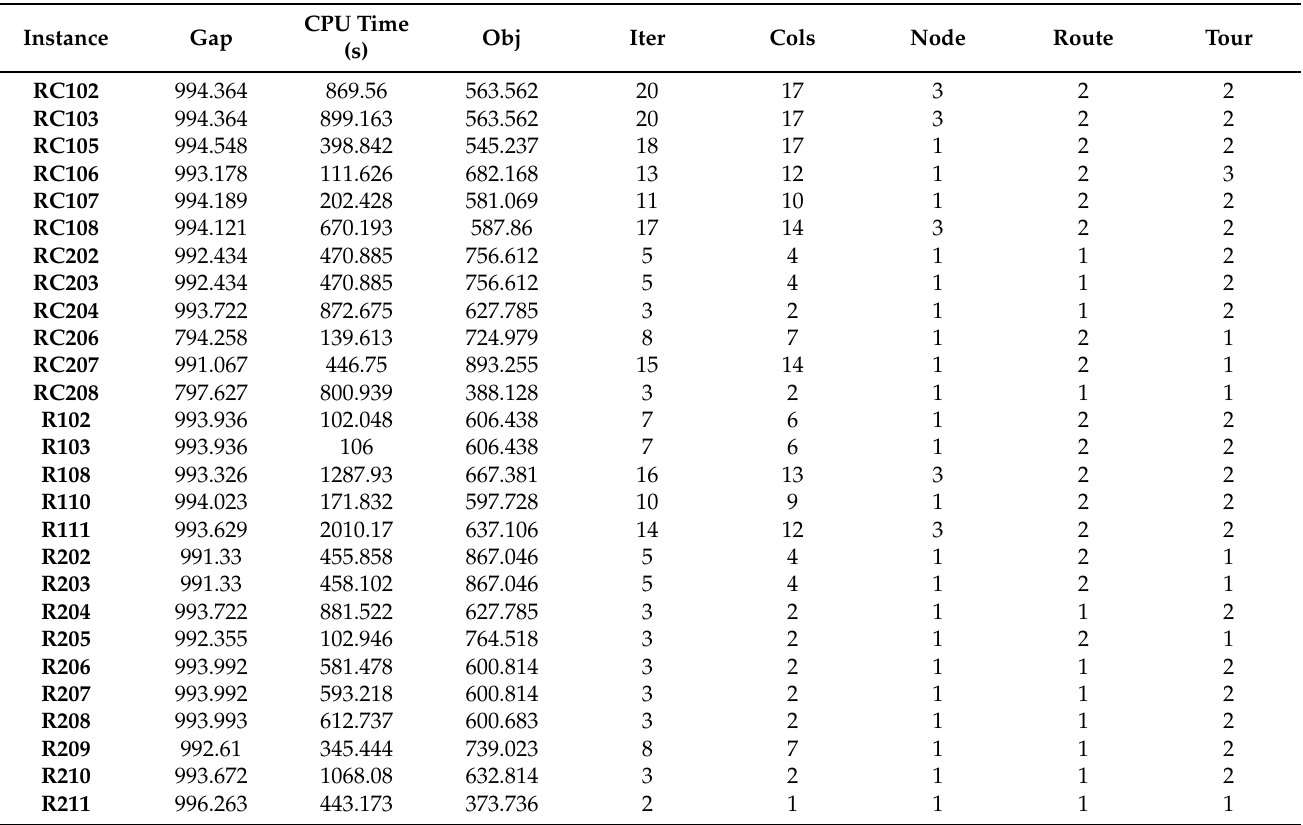
Table 4. Branch and Price for 10